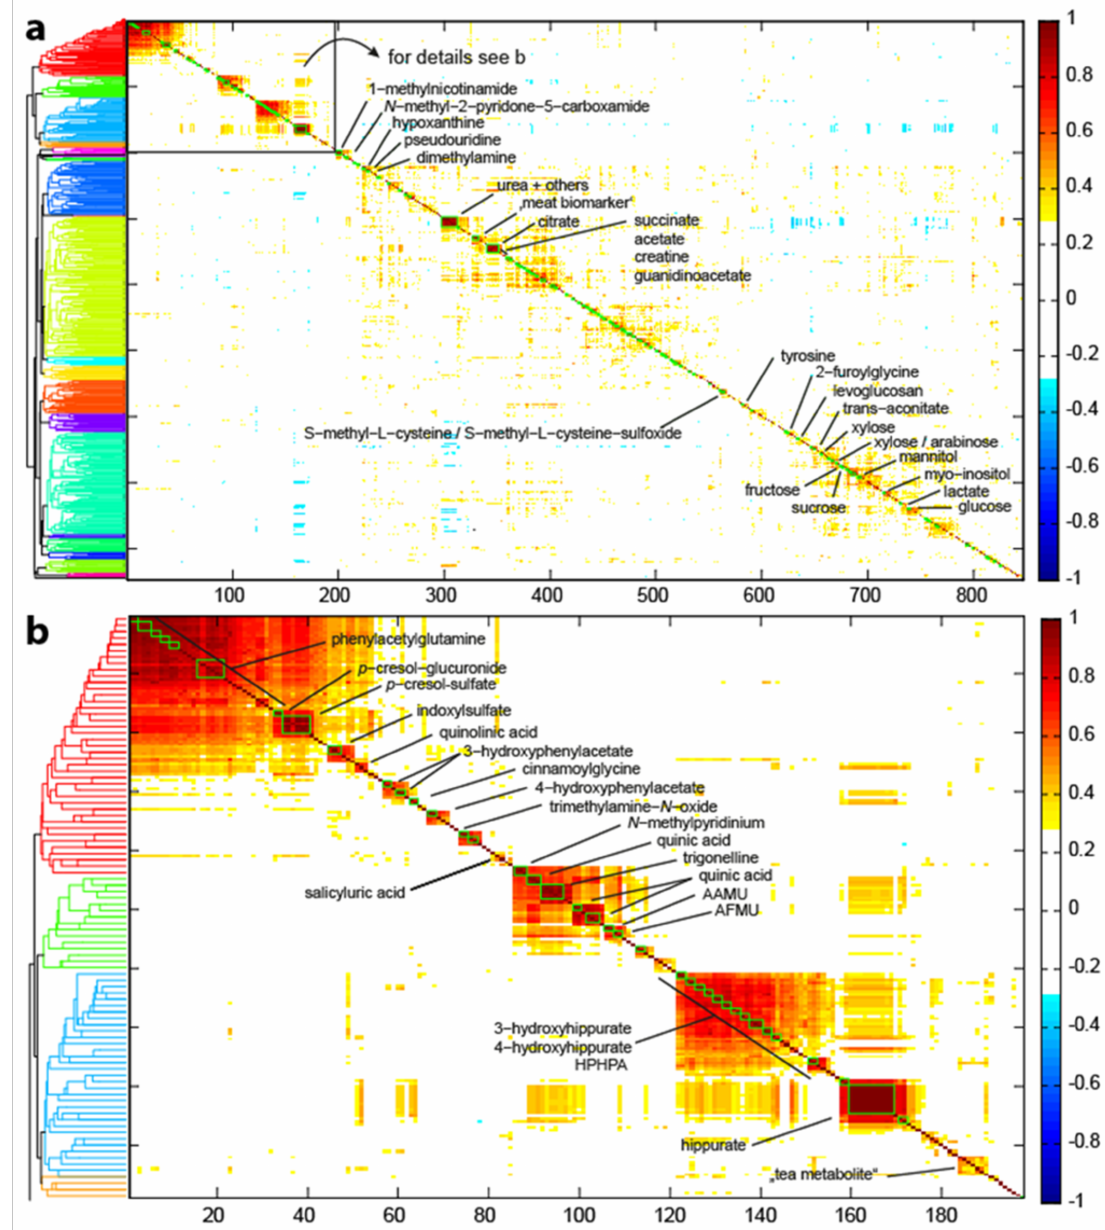
Figure 3. ( a ) Overview of all metabolite correlations from the 846 picked peaks. The x and y axis give the position of the peak in the metabolite correlation CLASSY cluster. Superimposed are the correlation coefficients, ranging from − 1 to 1 ( − 1 (blue) to 1 (red), the area with small correlation coefficients, i.e., − 0.3 to 0.3 is excluded (white)). The dendrogram (colour threshold 0.45) on the left highlights clusters. ( b ) The microbial metabolite cluster (from box in ( a )) summarizes metabolites from amino acid breakdown (red dendrogram branch), from coffee consumption (green branch) and hippurate and hydroxy-hippurate metabolites (blue branch). The chemical shifts of the associated metabolites are listed in Supplemental Table